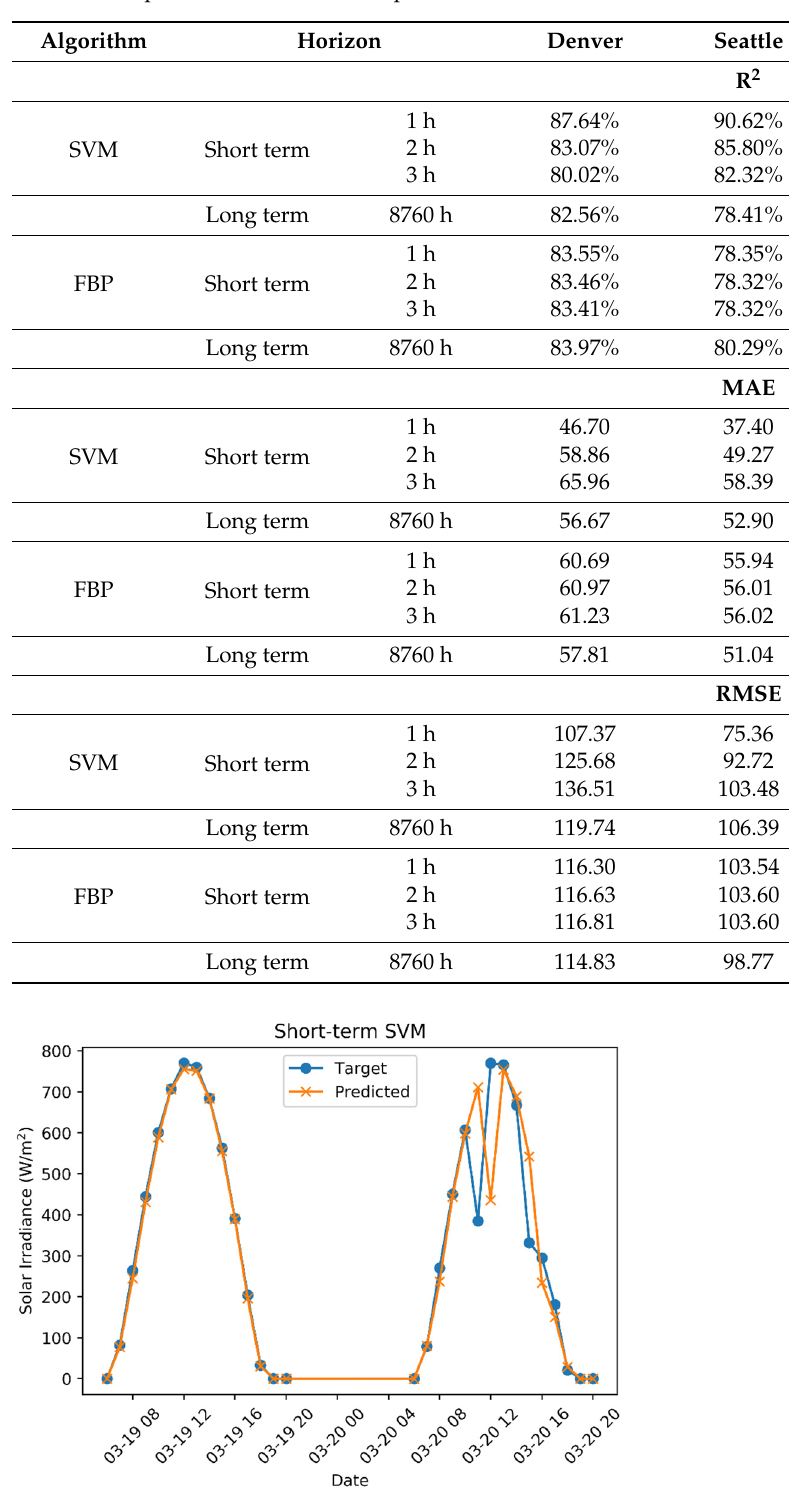
Table 7. Comparison of SVM and FBP performance in all cities.